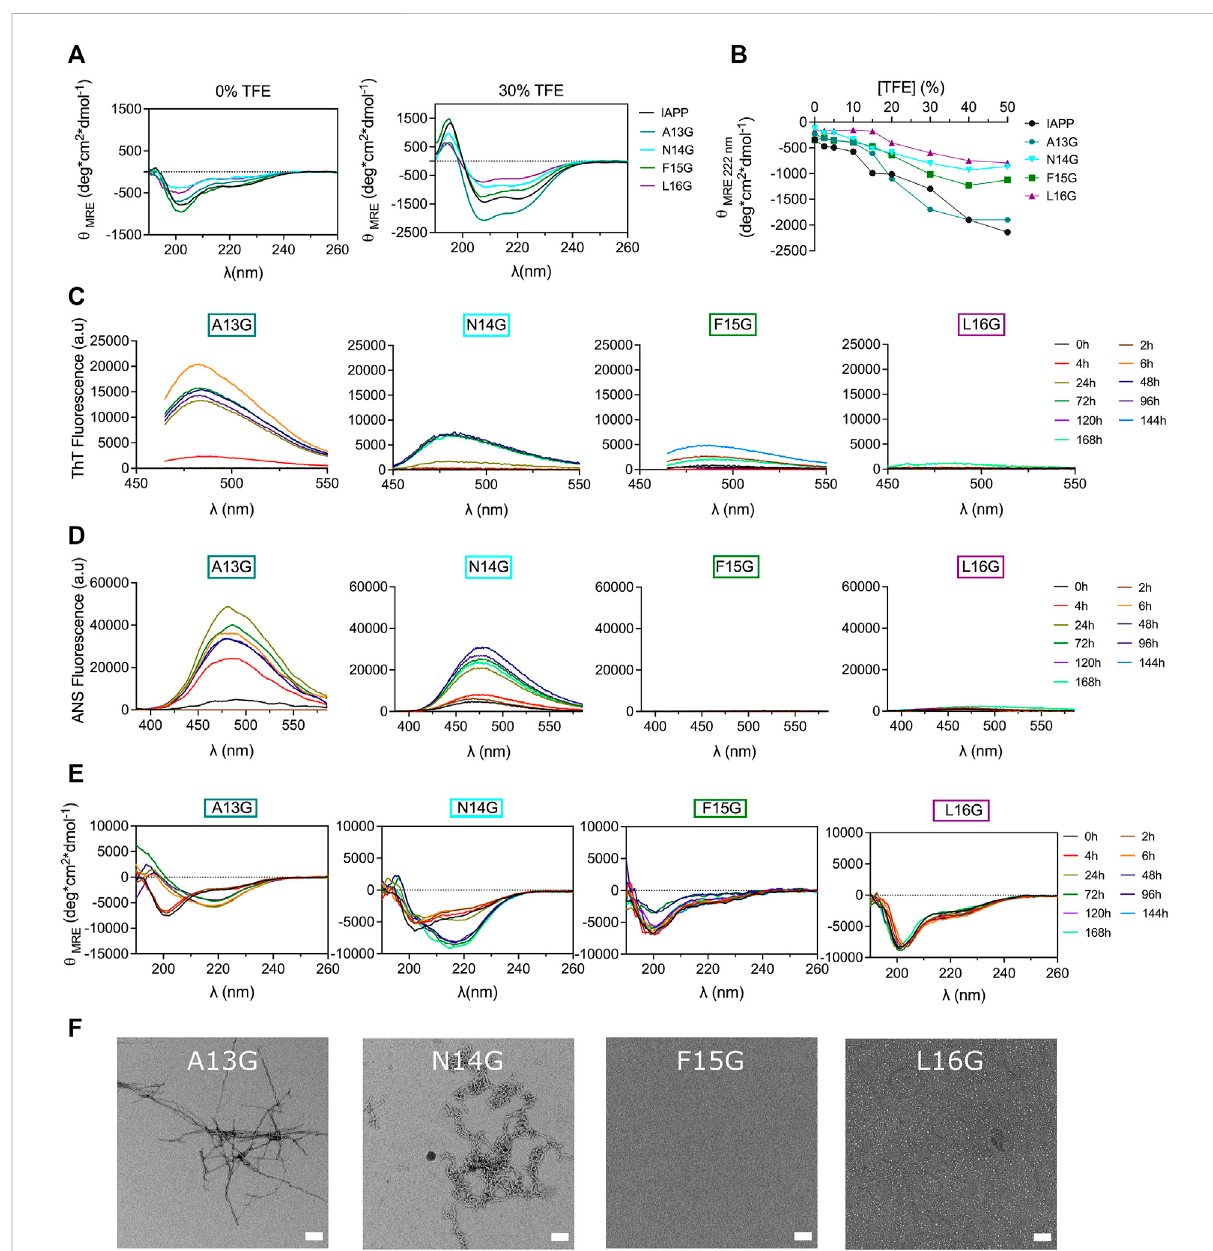
FIGURE 7 Effects of Gly substitution on IAPP amyloid self-assembly. (A) Far-UV CD spectra of IAPP and Gly-substituted analogs in Tris-HCl 20 mM in presence, or absence, of 30% TFE. (B) Effect of TFE on the mean residue ellipticity measured at 222 nm. (C – E) Peptides were incubated under quiescent conditions in 20 mM Tris-HCl buffer, pH 7.4, at a concentration of 50 μ M before (C) ThT fl uorescence, (D) ANS fl uorescence and (E) CD analysis. (F) TEM images obtained after for 48 h incubation. Scale bar: 100